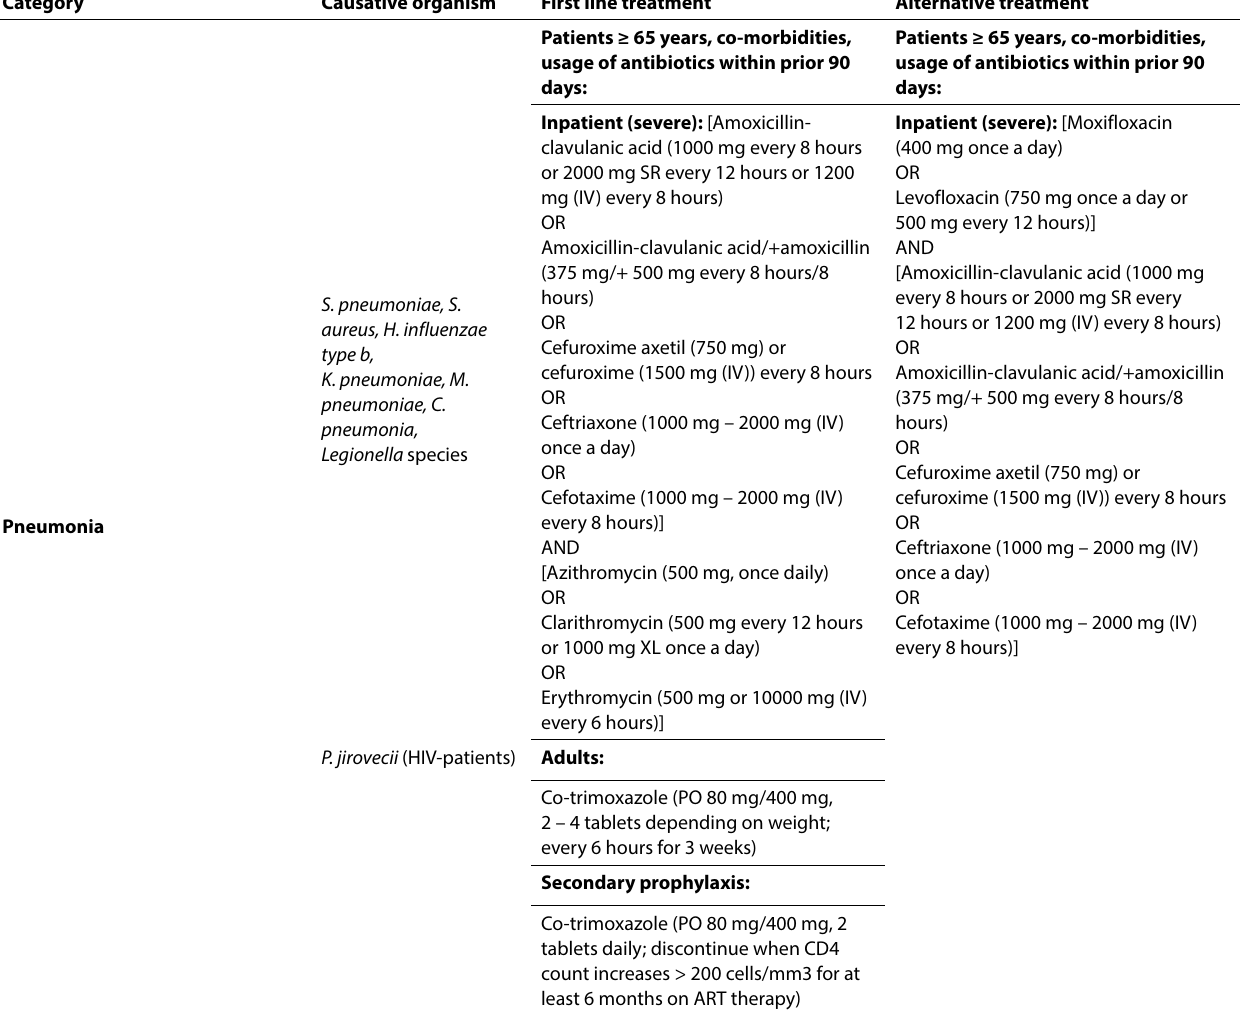
Table I. Main antibiotic treatment options for Upper and Lower Respiratory Tract Infections of bacterial origin (CONT.). 1,2-8,10,12-19,21,23,25-27